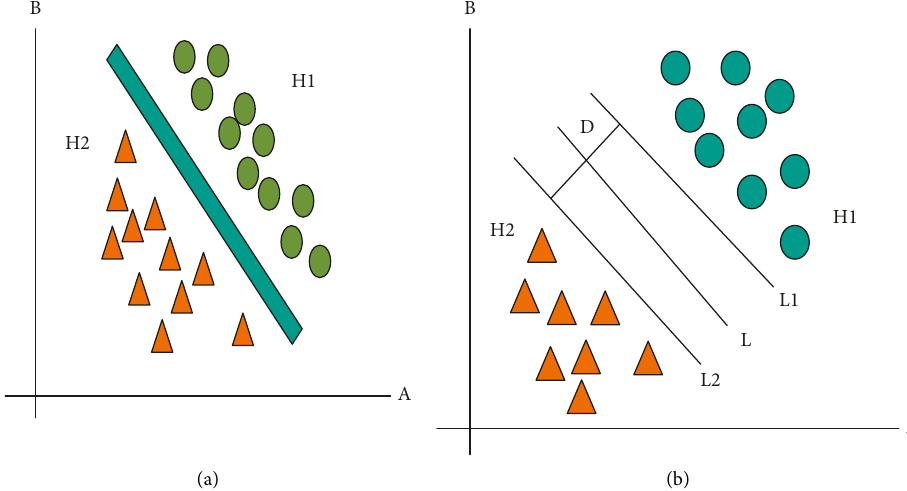
Figure 8: The basic principle of SVM is to find the optimal hyperplane by (a) basic principle of SVM; (b) optimal hyperplane.